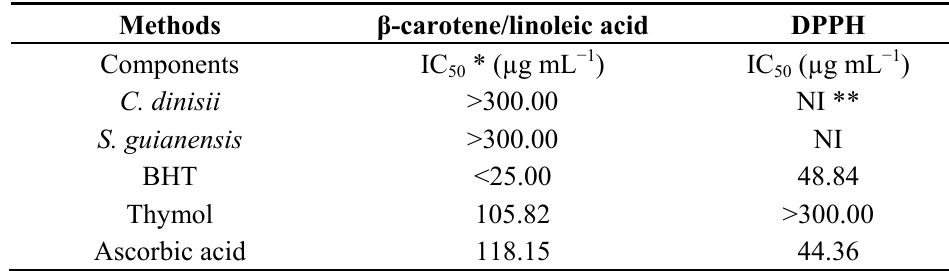
Table 3. Antioxidant activity of essential oils of S. guianensis and C. dinisii and of the standards thymol, BHT and ascorbic acid by the β -carotene/linoleic acid test and the DPPH radical sequestration